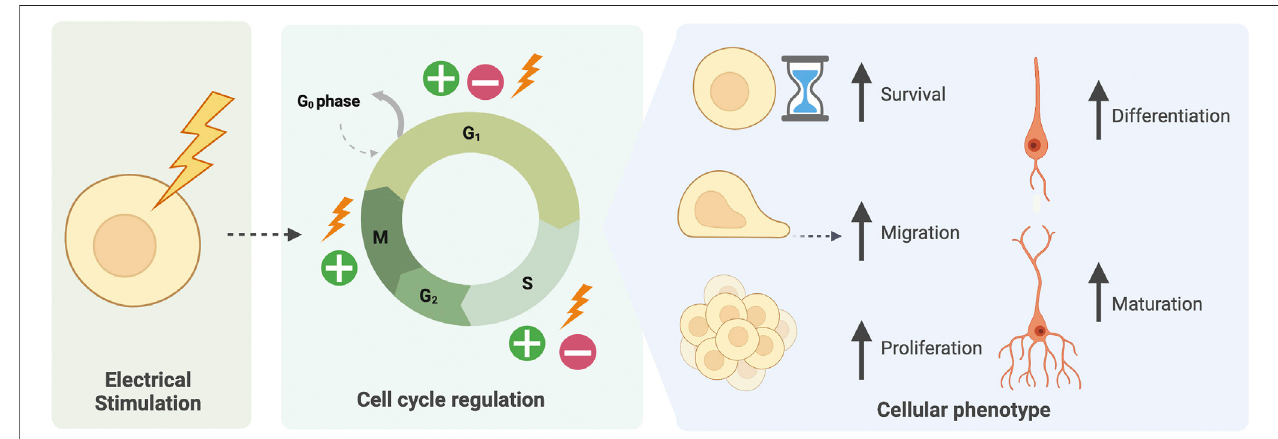
FIGURE 3 | Electrical stimulation of cells mediates cell-cycle related phenotypes. Electrical stimulation of CNS cells both in vivo and in vitro has been found to regulate the cell cycle at various phases. This may lead to an increase in cell survival, migration, proliferation, or alternatively exiting the cell cycle to increase cell differentiation and